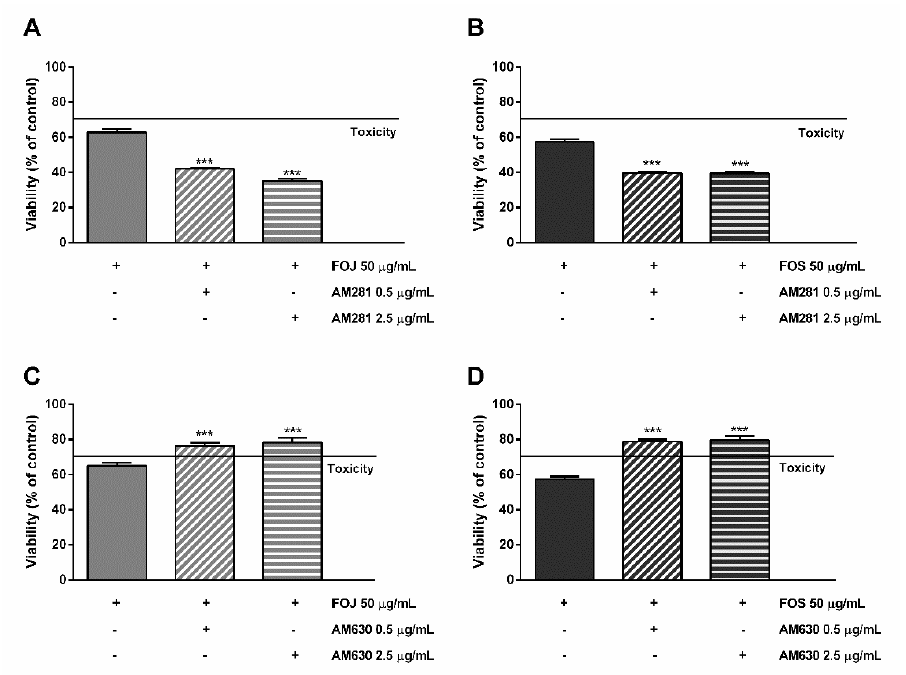
Figure 6. Cytotoxicity of 50 µ g/mL FOJ and FOS (organic extracts from Felina 32 hemp inflorescences collected in June and September respectively) after treatment with 0.5 and 2.5 µ g/mL AM281 ( A , B ) and AM630 ( C , D ) in MDA-MB-468 breast cancer cells. The cells were subjected to a 1 h pre-treatment with the antagonist, then incubated with the tested samples for 24 h. Data are expressed as mean ± SEM of at least three independent experiments with three technical replicates ( n = 9); *** p < 0.001, significant difference respect to the control (ANOVA + Dunnett’s Multiple Comparison PostTest).